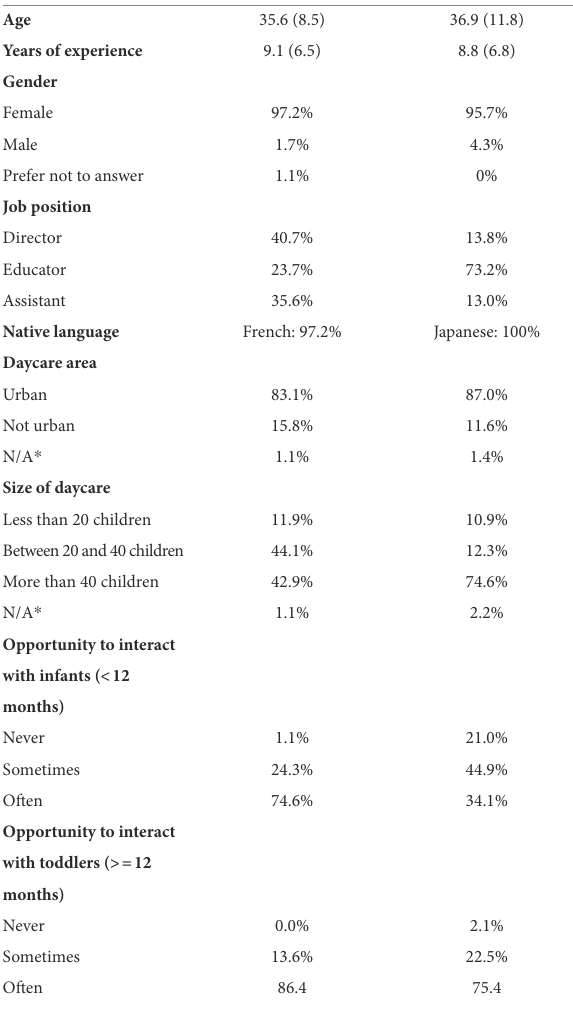
TABLE 1 Sample characteristics by